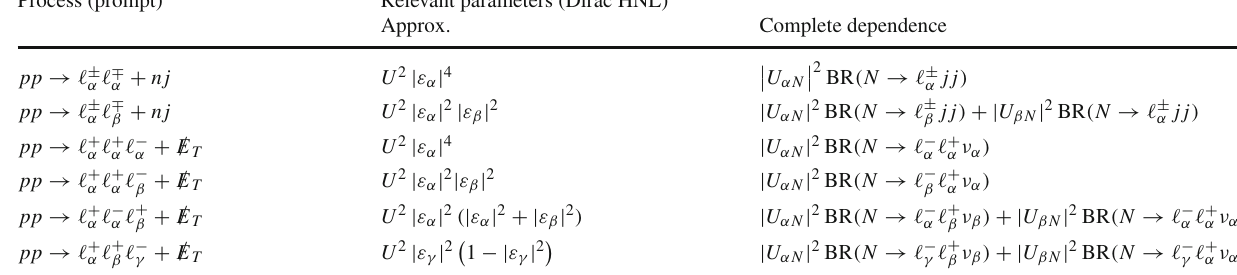
Table 3 Same as Table 2, but for Dirac HNL. We give the OS dileptons in this case, since the SS are not sensitive to Dirac HNLs Process (prompt) Relevant parameters (Dirac HNL) Approx.